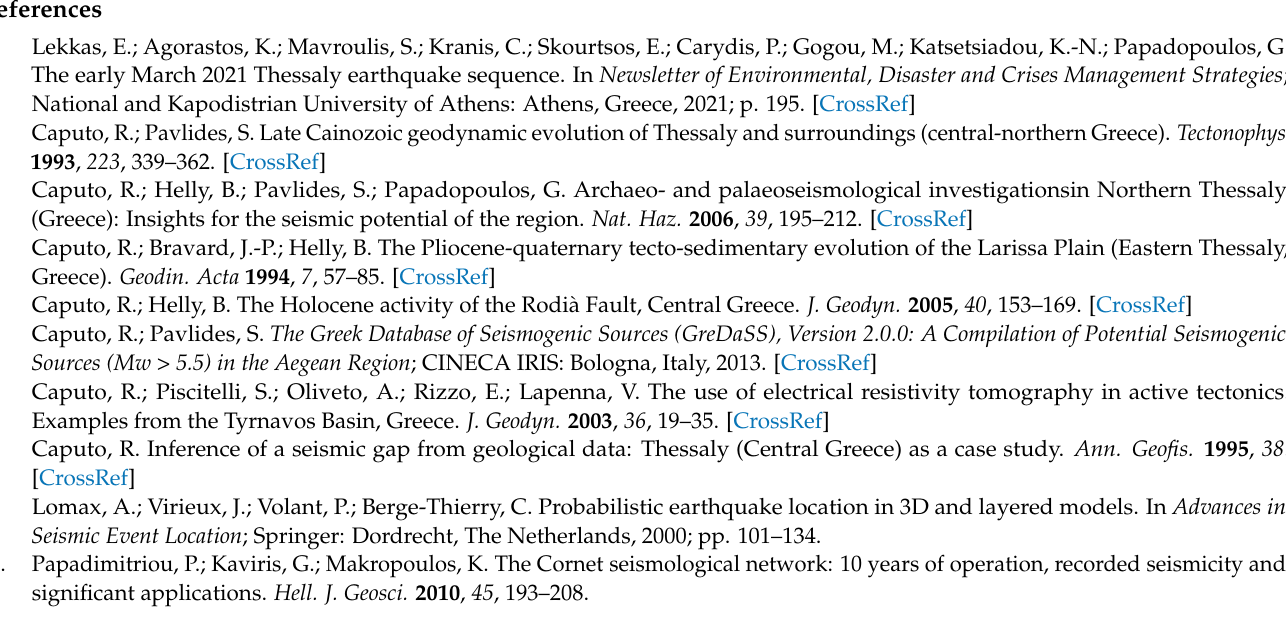
seismic activity and coseismic InSAR data pairs, Figure S2: Seismic stations used for earthquake locations, Figure S3: Error histograms for earthquake relocations, Figure S4: Map of the relocated epicenters, Figure S5: Additional Sentinel-1 interferograms (wrapped), Figure S6: Additional Sentinel- 1 interferograms (unwrapped), Figure S7: E–W and vertical displacement maps computed from InSAR data, Figure S8: Uniform slip modeling for T3 (b + g + l + q, jointly) and T4 (f + k + p + u, jointly); Figure S9: Uniform slip modeling for T3 (b + g and l + q); Figure S10: Uniform slip modeling for T4 (f + k and p + u); Figure S11: Uniform slip modeling for T1 (a) and T2 (d); Figure S12: Uniform slip modeling for T5 (c + h and m +